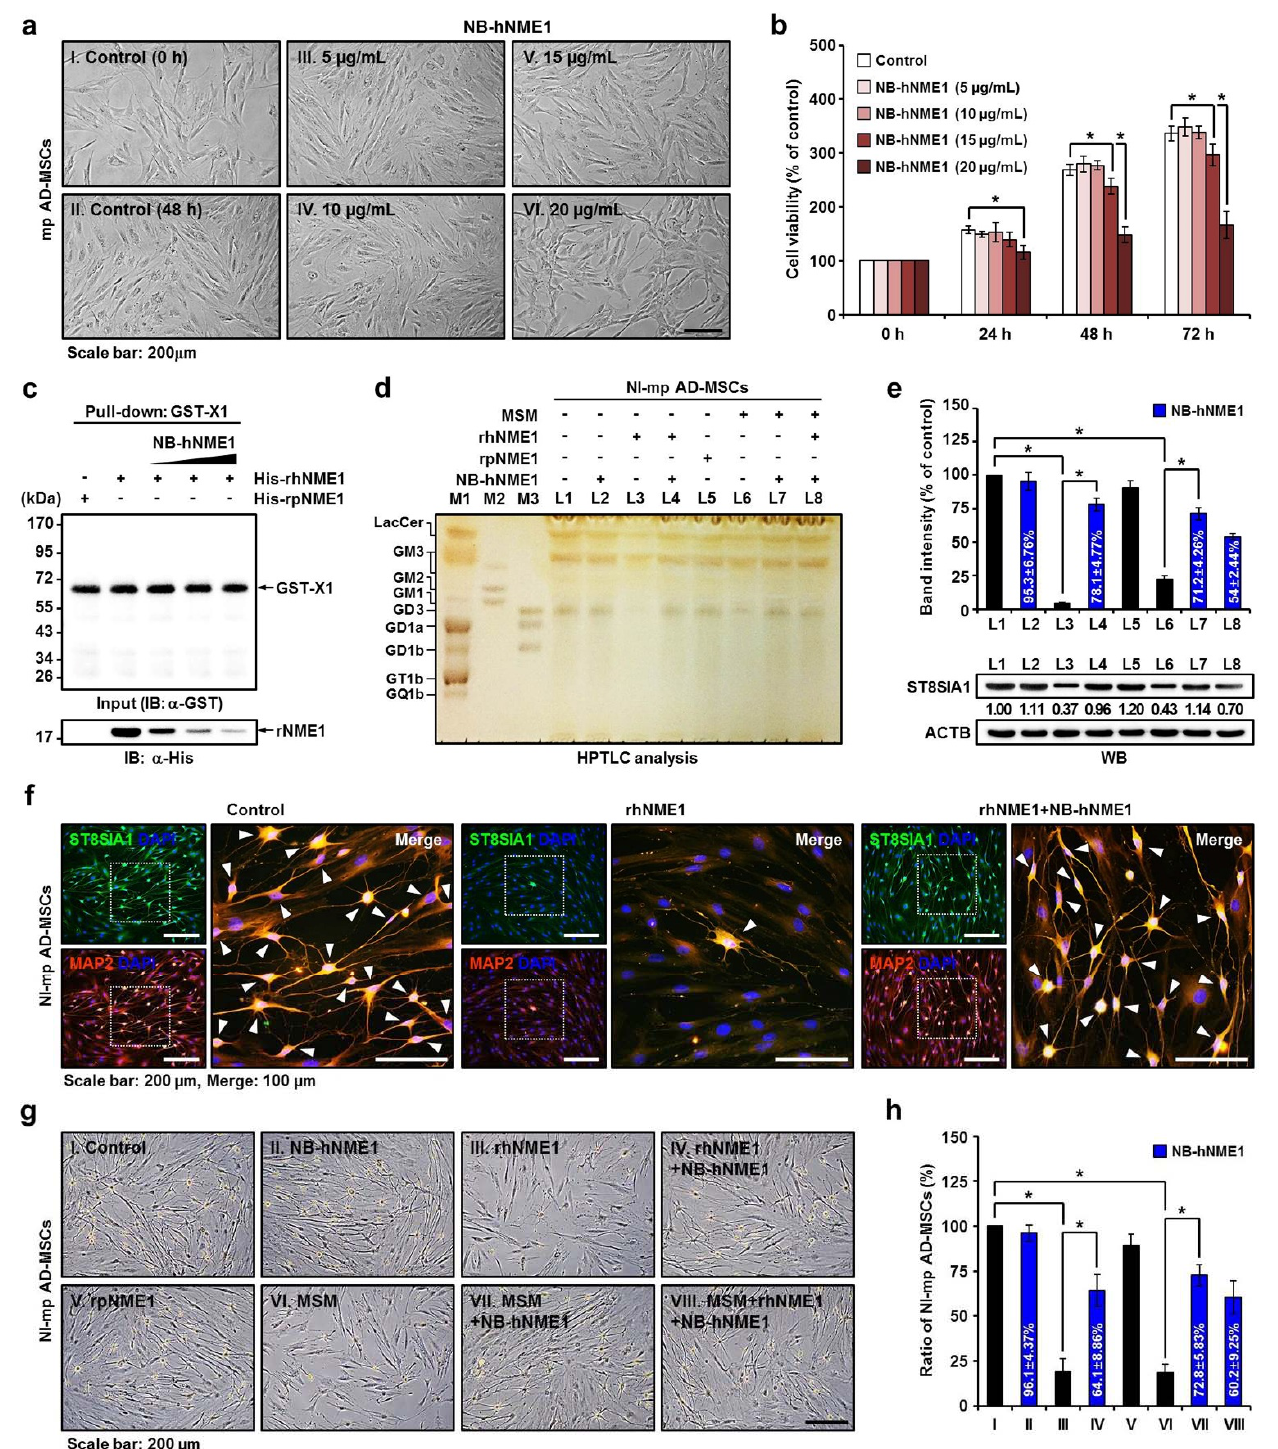
Figure 7. The effects of NB-hNME1 as an hNME1 suppressor in mp AD-MSC differentiation. ( a ) Determination of cytotoxicity and morphological changes in mp AD-MSCs after treatment with different doses (5, 10, 15, and 20 μ g/mL) of NB-hNME1 for 48 h. ( b ) Cell viability was quantified by an MTS assay at 24, 48, and 72 h post-NB-hNME1 treatment. Data are presented as mean percentage levels ± SD ( n = 3; * p < 0.05). ( c ) The effects of NB-hNME1 on GST-X1 protein and His-rhNME1 binding affinity. Results were analyzed by SDS-PAGE followed by IB analysis with the specific α -GST and α -His antibody, revealing that NB-hNME1 (5, 10, and 15 μ g/mL) inhibits the interaction of hNME1 with pST8SIA1. ( d ) HPTLC of gangliosides in NI-mp AD-MSCs. Treatment with rhNME1 or MSM reduced ganglioside GD3 expression (L3 or L6), whereas co-treatment with rhNME1 or MSM and NB-hNME1 (L4 or L7) recovered ganglioside GD3 expression in NI-mp AD-MSCs. M1, adult mouse brain gangliosides; M2 and M3, ganglioside standard markers; L, line. ( e ) Quantification of